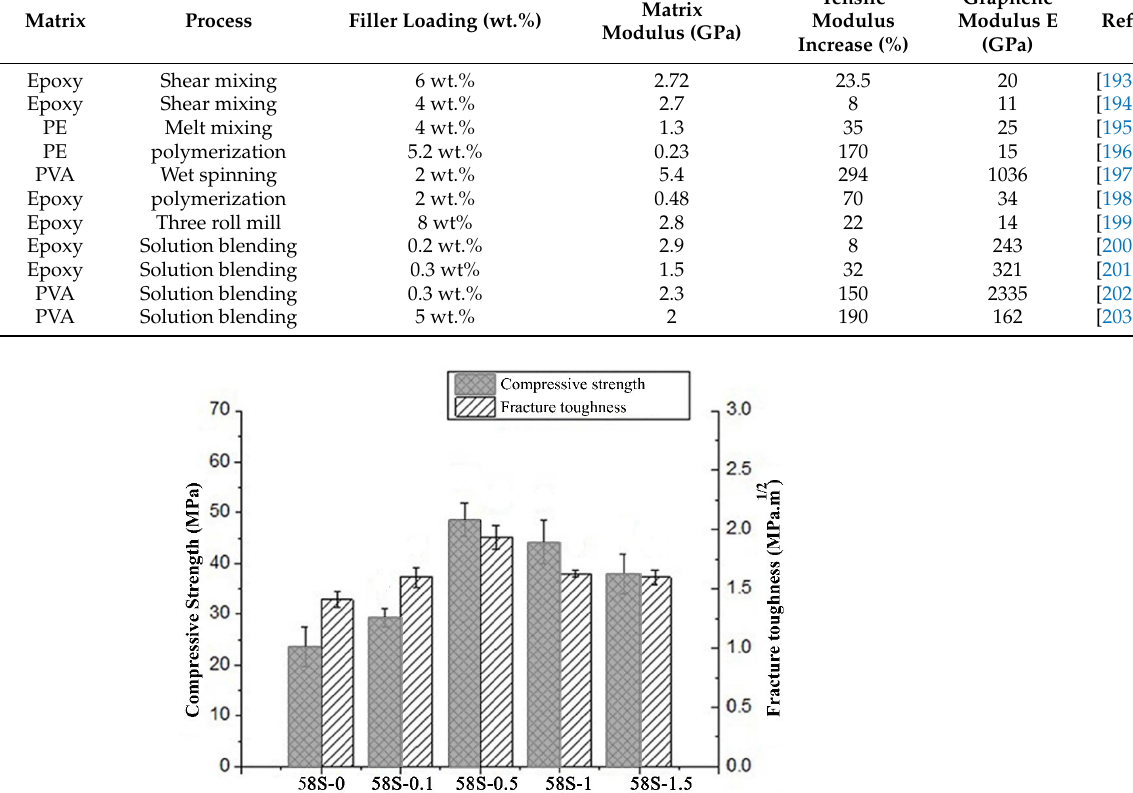
Figure 19. ( a ) Stress–strain diagrams; ( b ) bending modulus and strength of the composite samples. Reproduced from [213] (CC BY). Nanoindentation is a widely used technique for measuring the nano and microscale mechanical properties in nanomaterials and nanocomposites. This technique has been commonly used in determining the mechanical properties of polymers [204–208]. Re- cently, it has been used to measure mechanical properties of nanocomposites. Shokrieh et al. [206] used nanoindentation to evaluate the mechanical properties of graphene nano- composites. According to this investigation, the mechanical properties of a pure polymer matrix are remarkably improved by the addition of small amounts (0.05 wt.%) of gra- phene nanoplatelets (GNP). Shen et al. [207] used nanoindentation to study mechanical properties of clay nano- composites with different polymer matrices. Aldousiri et al. [208] used nanoindentation